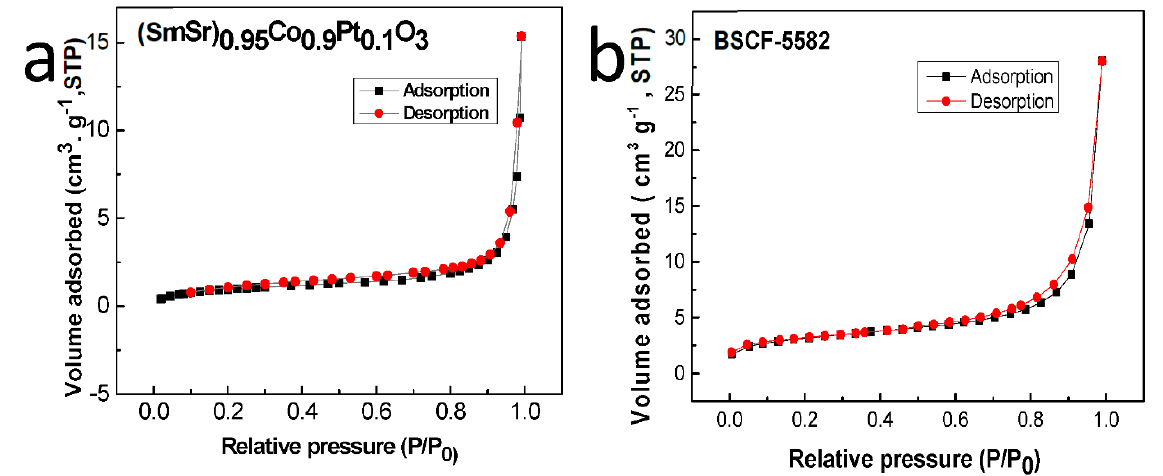
Figure 6. Nitrogen adsorption/desorption isotherm patterns of (SmSr) 0.95 Co 0.9 Pt 0.1 O 3 ( a ) and Ba 0.5 S r0.5 Co 0.8 Fe 0.2 O 3 (BSCF-5582) ( b ).